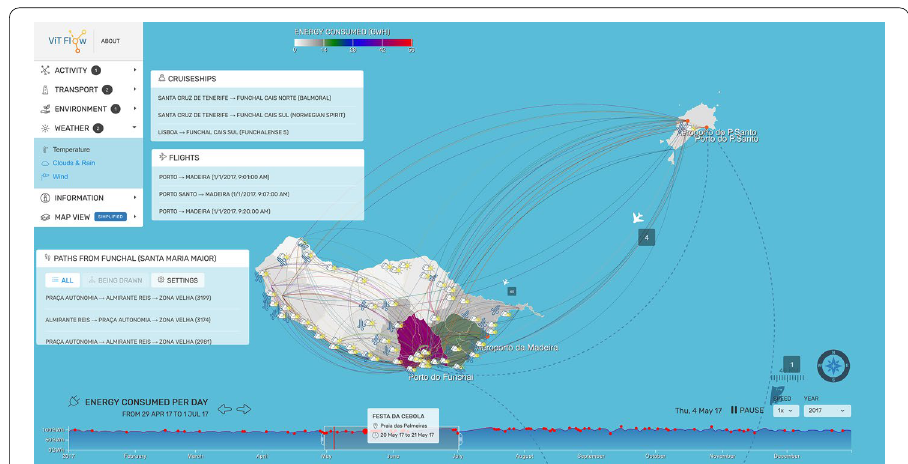
Fig. 3 A screenshot of the ViTFlow rich interface where different datasets/layers are visualized in a given